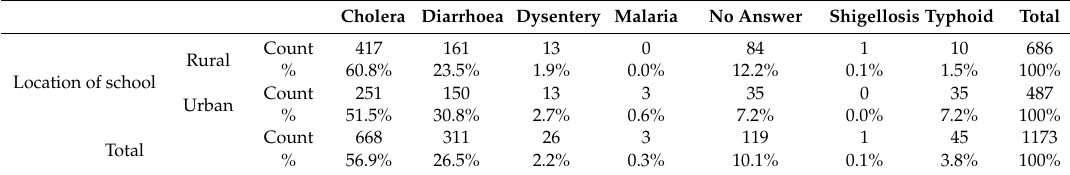
Table 3. Knowledge about